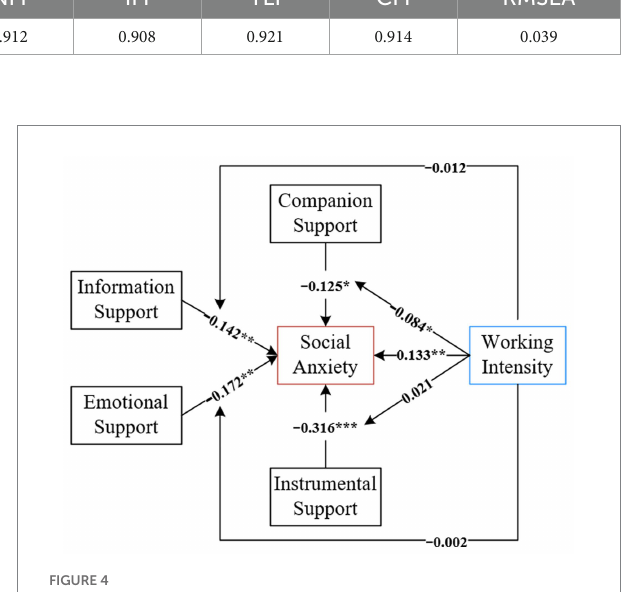
FIGURE 4 Results of the structural model. * p < 0.01; ** p < 0.05; *** p <